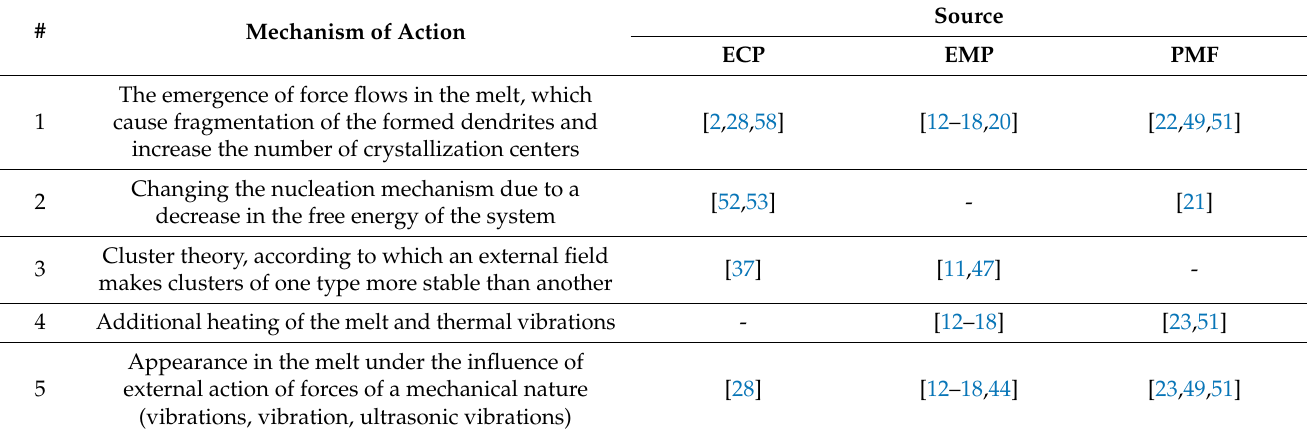
Table 10. Impulse action